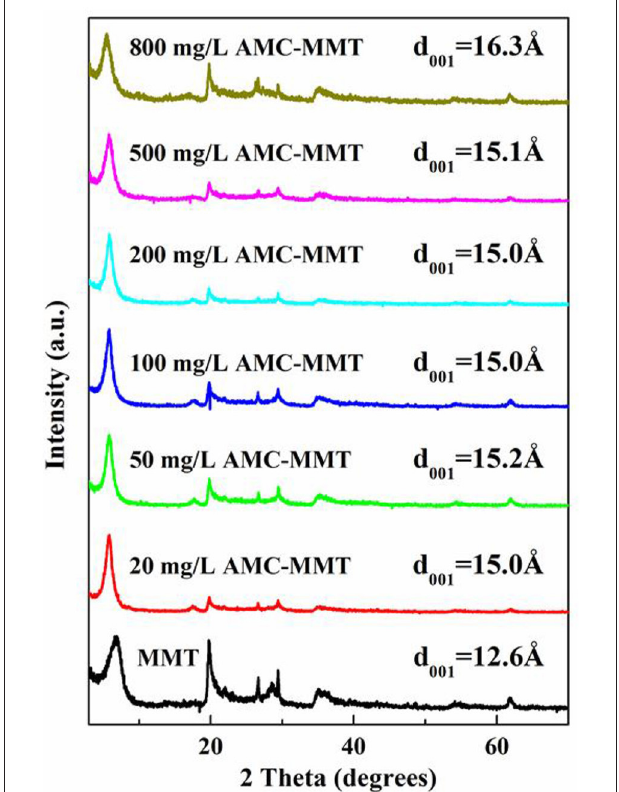
FIGURE 2 | X-ray diffraction patterns of MMT was inserted with AMC in the interlayer, which was affected by initial AMC concentrations (mg/L).